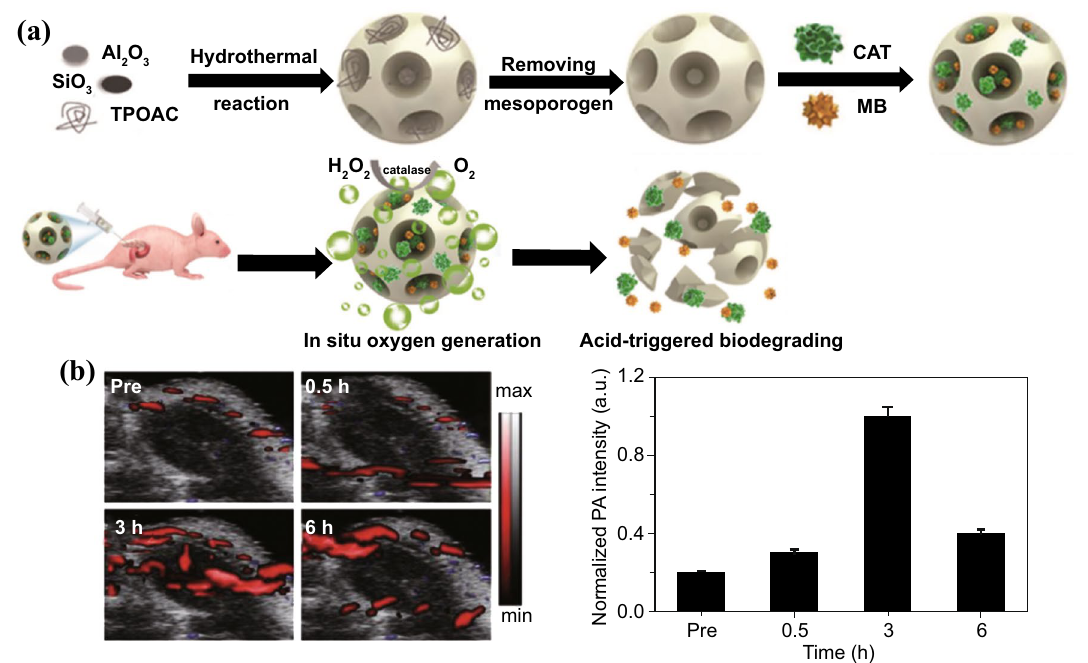
Fig. 3 a Paradigm of the fabrication of mesoporous hierarchical zeolite nanocarriers loading catalase and MB characterized with oxygen gen- eration and acid-triggered degradation. b In vivo 2D photoacoustic images and quantitative results of the blood oxyhemoglobin saturation in the tumor region at different time points after the intratumoral injection of the ZCM nanocapsule. Reproduced from Ref. [40] with permission. Copyright © The Royal Society of Chemistry